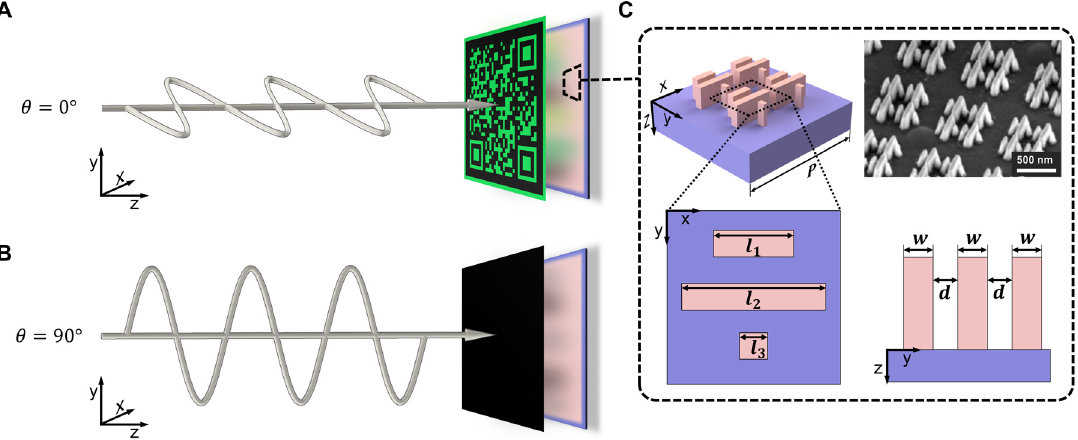
Figure 1: Schematic illustration of switchable metasurfaces. Colored images are switched on and off by the polarization angle ( θ ). The colors appear under (A) horizontally polarized incident light ( θ = 0 ° ) and concealed under (B) vertically polarized light ( θ = 90 ° ). (C) Schematic of the subpixel and superpixel with the periodicity ( P ). A single subpixel consists of a triple-nano fi n structure with the same height ( h ) and width ( w ), and distance ( d ) with varied lengths ( l 1 , l 2 , and l 3 ). One superpixel consists of four subpixels. An oblique angle SEM image of a fabricated sample is shown in the top right